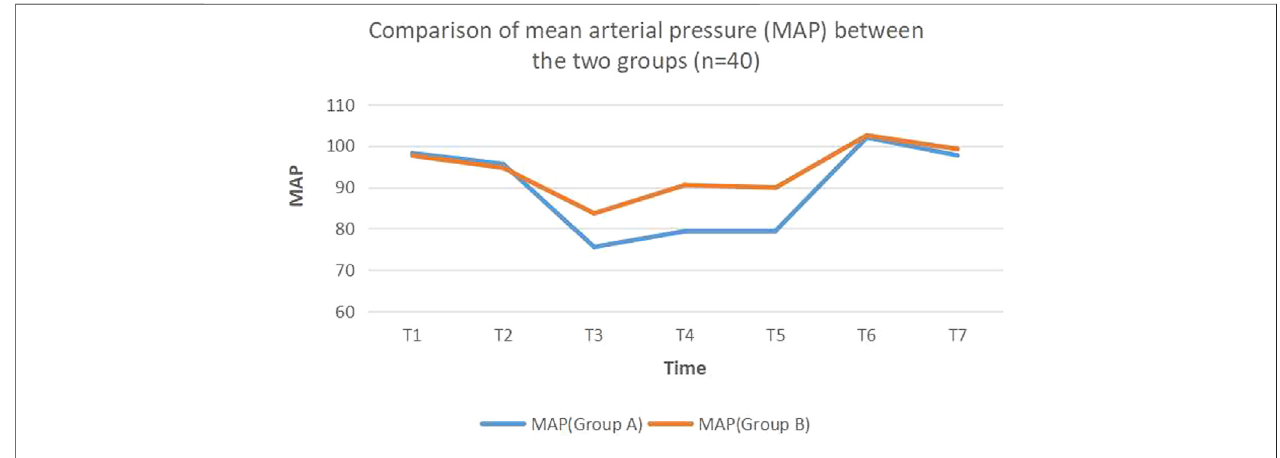
FIGURE 1 | Comparison of mean arterial pressure (MAP) between.